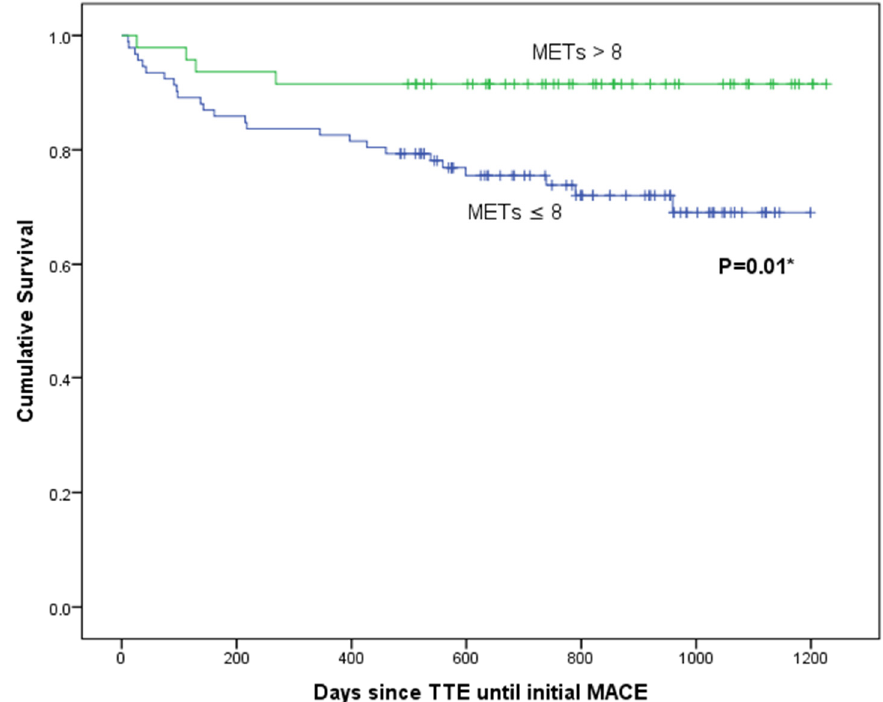
Figure 1. Kaplan–Meier estimates of exercise capacity from time of initial transthoracic echocardio- gram to first major adverse cardiac event (MACE). METs, metabolic equivalents; TTE, transthoracic echocardiogram. * Log-rank statistic.